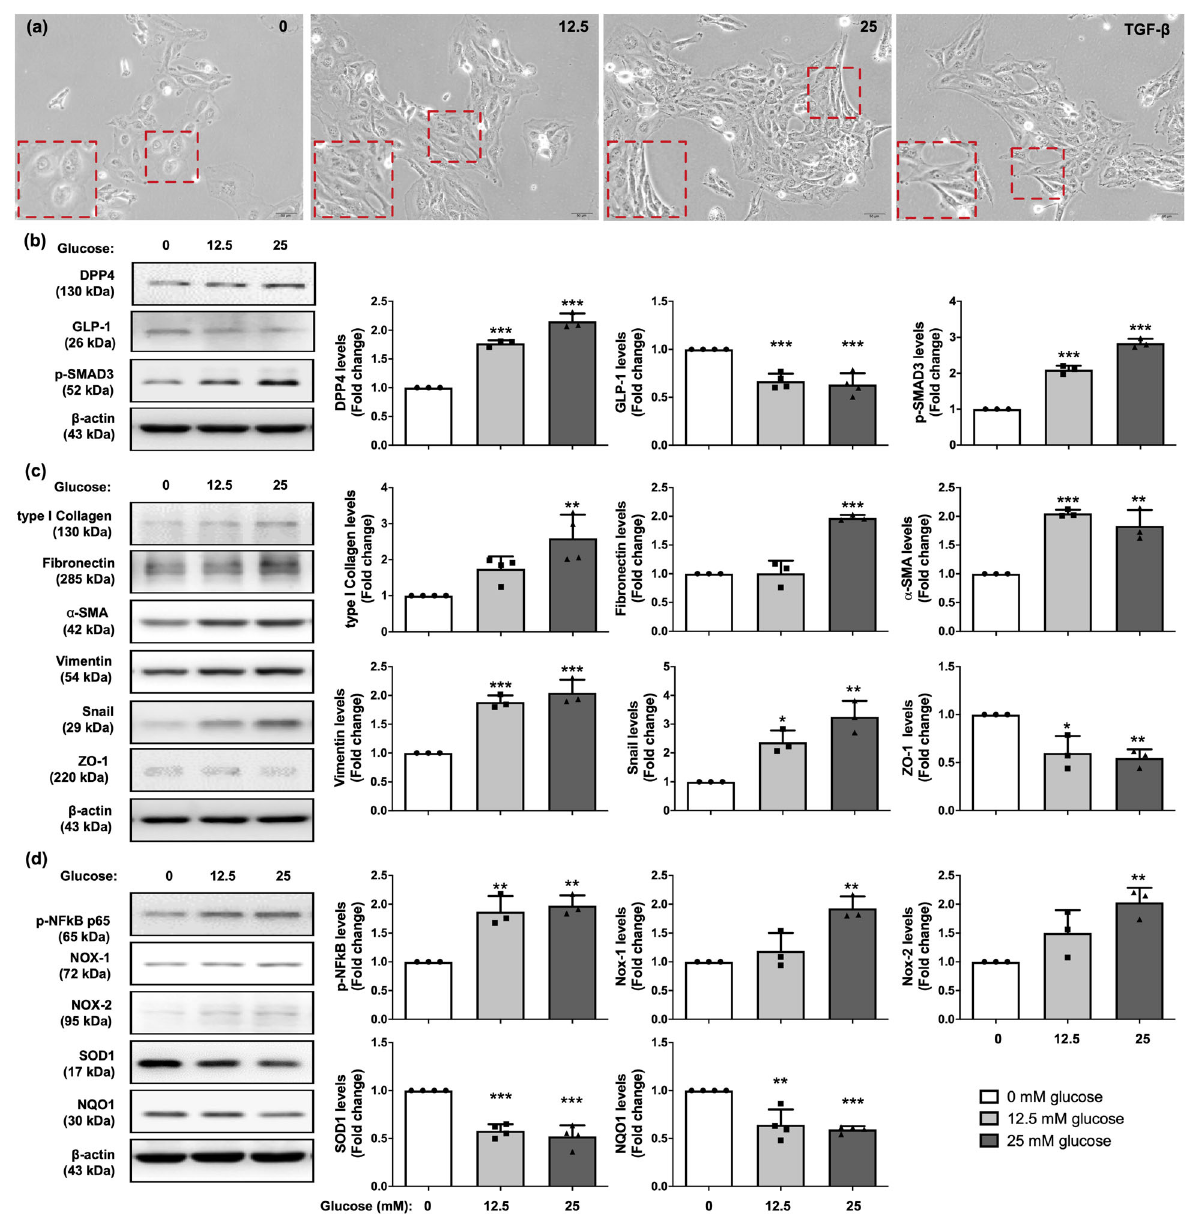
Fig. 1 Glucose treatment induced increase of DPP4 levels, EMT process, oxidative stress generation, and in fl ammation in mesothelial cells. a Met-5A cells were exposed in 0, 12.5, 25 mM D-glucose, and 2 ng/ml TGF- β 1 recombinant protein for 120 h and observed cell morphology by microcopy at 200×. The Met-5A cells were changed from cobble stone shapes to fi broblast-liked morphologies in glucose-dependent manner. TGF- β 1 treatment was as a positive control of EMT. Scale bars: 50 μ m. b Western blotting was performed to detect the protein levels of DPP4, p-SMAD3, and GLP-1. Quantitative results were shown in the right panel. The relative levels were normalized and compared by 0 mM glucose concentration. c Western blotting was performed to detect the protein levels of the mesenchymal markers (type I collagen, fi bronectin, α -SMA, vimentin, Snail) and epithelial marker (ZO-1). d Glucose treatment enhanced phosphorylated NF-kB activation, elevated the levels of ROS generated enzyme (NOX-1, NOX-2) but declined antioxidant enzymes (SOD1, NQO1) to cause ROS accumulation detected by immunoblotting. Data represents the analysis of at least 3 independent experiments and shows mean ± SD. * indicates p -value <0.05; ** represents p -value <0.01; and *** is p -value mesenchymal marker, by immunohistochemical analysis. As In situation of peritoneal fi brosis, TGF- β /SMAD3 signaling expected, microscopic fi ndings demonstrated that the thickness of axis has been recognized to mediate EMT process 34,35 . The results of the present study also displayed the signi fi cant upregulations of positively stained type I collagen was signi fi cantly increased in type I collagen, TGF- β , SMAD3, and Twist in PF-344 group PF-F344 group as compared with SC group of wild-type rats, (Fig. 5d, Supplementary Fig. 1). On the other hand, DPP4 and that was signi fi cantly reduced in PF-DPP4 de fi cient rats de fi ciency signi fi cantly not only suppressed CG-induced protein (Fig. 5a, b). Meanwhile, the protein level of DPP4 in the perito- expression of DPP4 but also downregulated the mesenchymal neal membrane was signi fi cantly enhanced to 4-folds in PF-F344 marker (i.e., type I collagen) and TGF- β /SMAD3 signaling axis group as compared with SC-F344 group that was decreased in (Fig. 5d, f), suggesting DPP4 de fi ciency alleviated CG-induced PF PF-DPP4 de fi cient rats again (Fig. 5d).